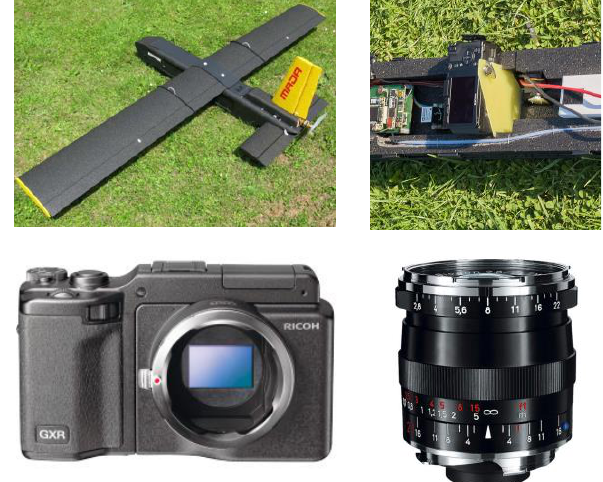
Figure 2: Platform Bormatec Maja (top) with camera Ricoh GXR Mount A12 with Zeiss Biogon 21 mm (bottom).